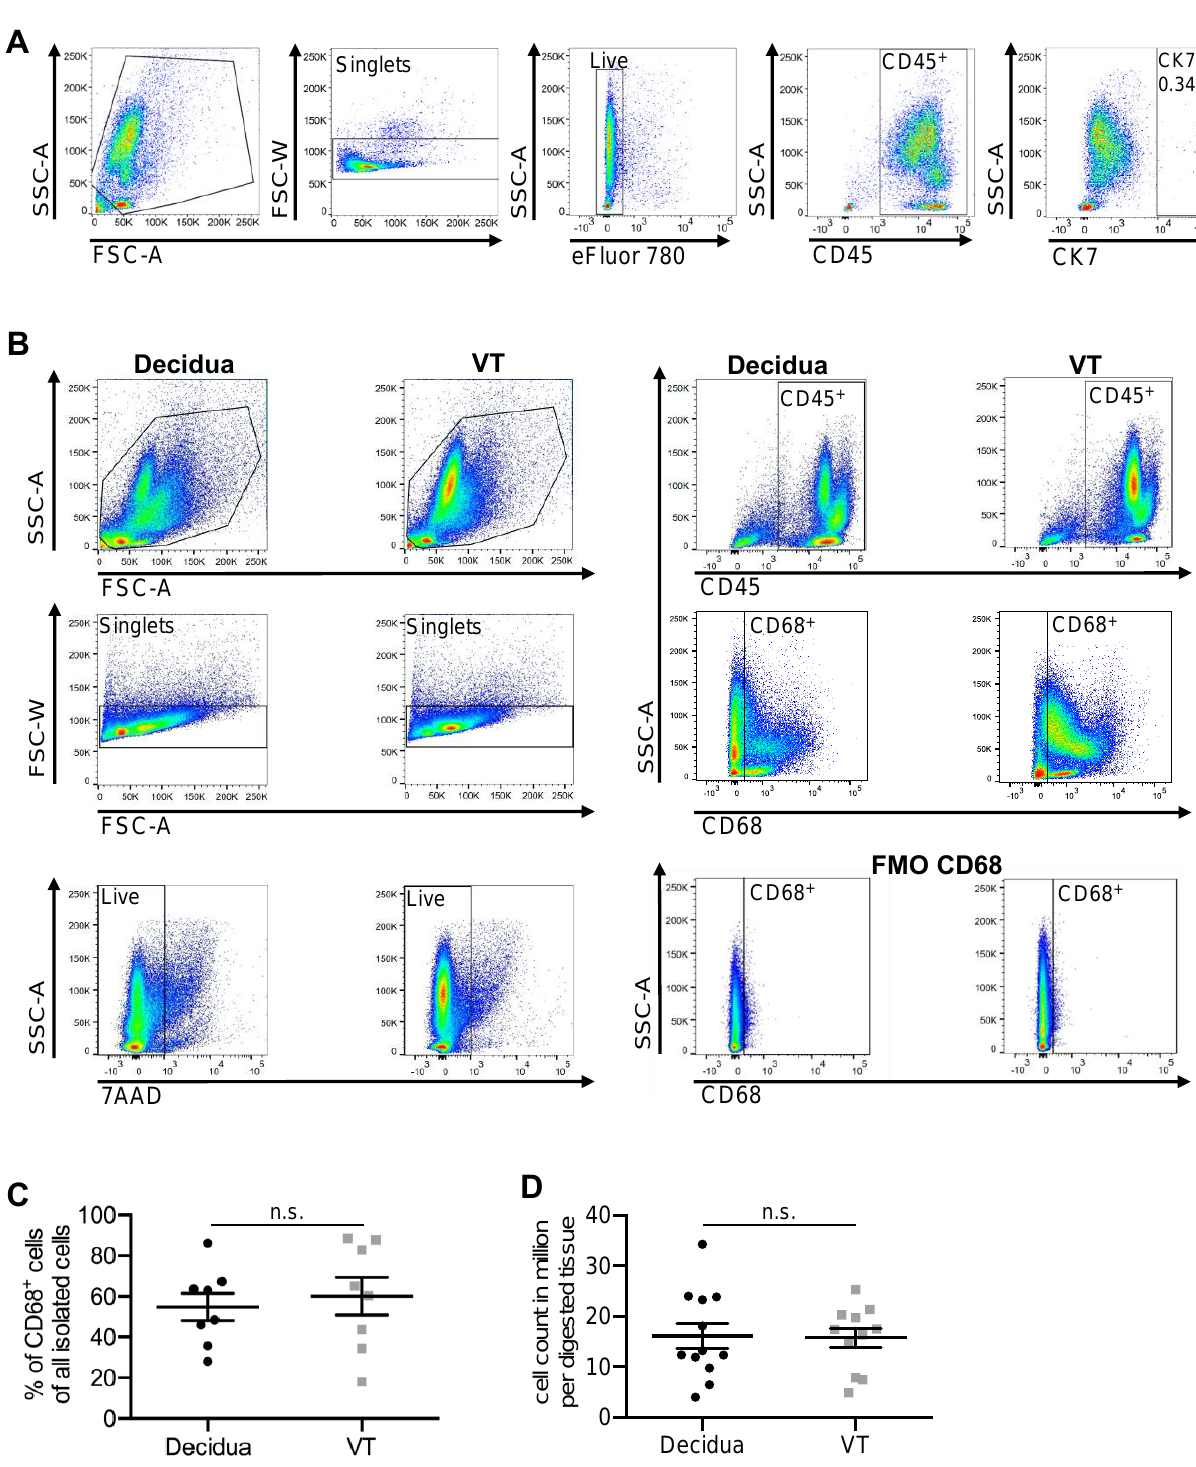
Figure 1. Cell yield and purity — ( A ) FACS images of isolated cells with CK7 as trophoblast marker and the corresponding FMO. ( B ) Representative FACS images of isolated cells from decidua and VT. ( C ) Percentage of CD68 + cells in FACS analysis of decidua (35 gr.) and VT (150 gr.). Data are mean ± S.E.M., n = 8, n.s. p > 0.05 (decidua vs. VT) by Mann – Whitney-U-Test. ( D ) Dotplots of cell counts in million per digested tissue (35 gr. decidua and 150 gr. VT) of the immune cell layer. Data are mean ± S.E.M., n ≥ 11, n.s. p > 0.05 (decidua vs. VT) by Mann – Whitney-U-Test.